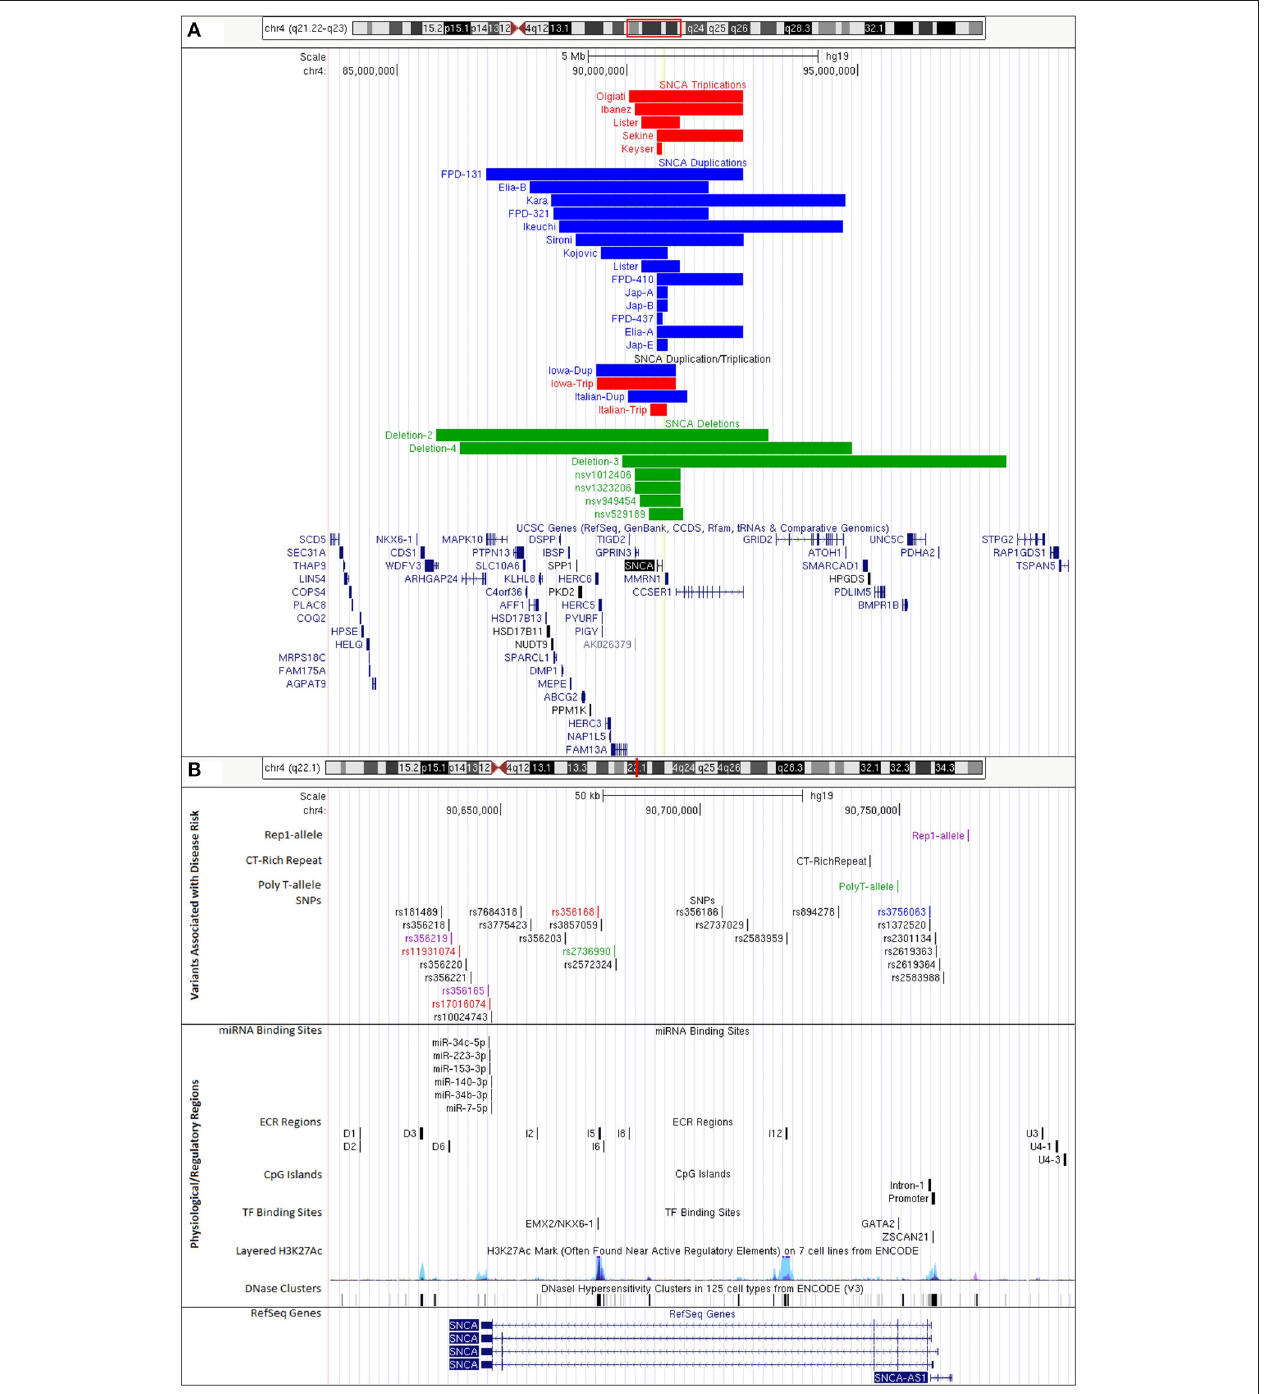
FIGURE 1 | UCSC Genome Browser custom tracks for PD-risk associated variants and regulatory regions impacting SNCA expression. (A) CNVs of SNCA locus on chromosome 4q21.23-q22.3 (GRCh37/hg19, chr4:84,239,011-98,739,011). Colors indicate gene copy numbers. Red: SNCA CNV triplications; blue: SNCA CNV duplications; combination: SNCA triplication (red) and duplication (blue); green: SNCA CNV deletions. IDs given to tracks were either based on family identifiers from literature or are first author’s last name of publication where case/family has been reported. (B) Disease variants and regulatory regions of the SNCA genomic locus on chromosome 4q22.1 (GRCh37/hg19, chr4:90,608,984-90,793,984) (details in Supplementary Tables 2–4). Colors indicate functional changes related to variants. Red: total mRNA expression; blue: affects SNCA splice-isoform; green: SNCA methylation; pink: multiple associated functions. Additional tracks include microRNA and transcription factor binding sites, CpG islands, and integrated regulation from ENCODE (Layered H3K27Ac and DNase Clusters). (Supplementary Table 5 lists all positions to build custom tracks in UCSC Genome Browser).